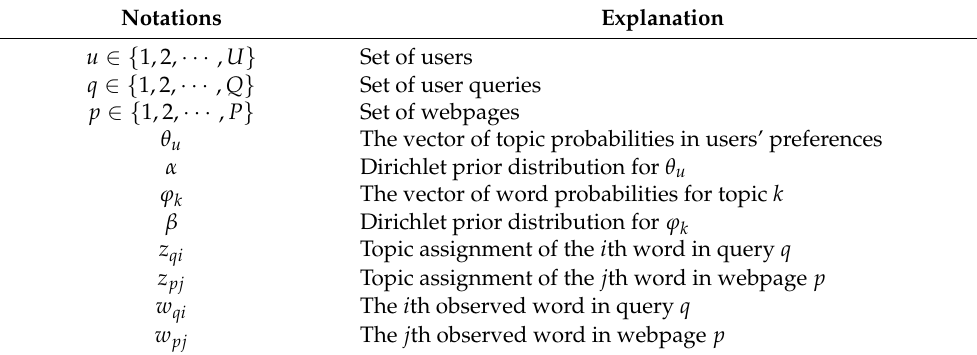
Table 1. Summary of the main